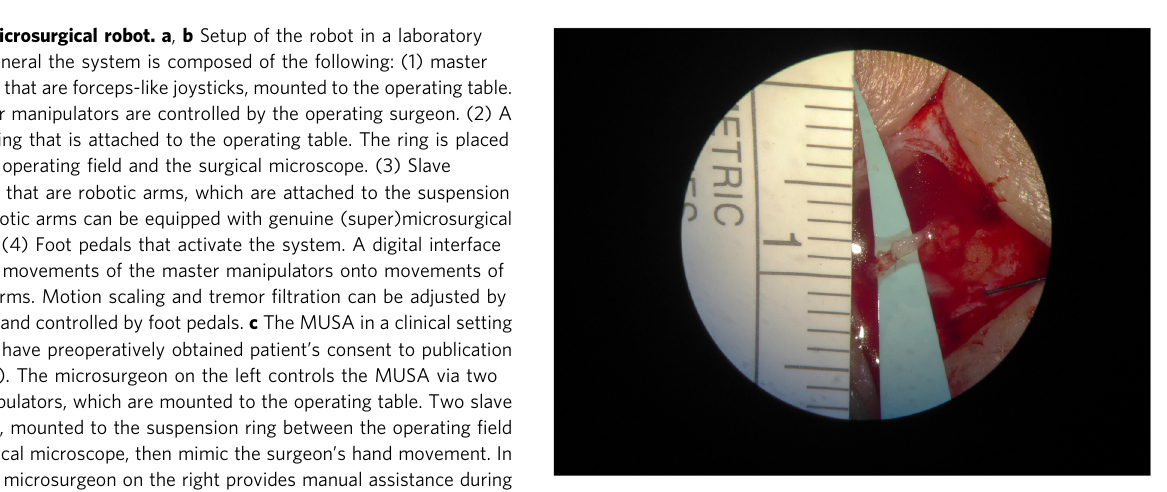
Fig. 2 Microscopic view of a lymphatico-venous anastomosis. View through the microscope on a